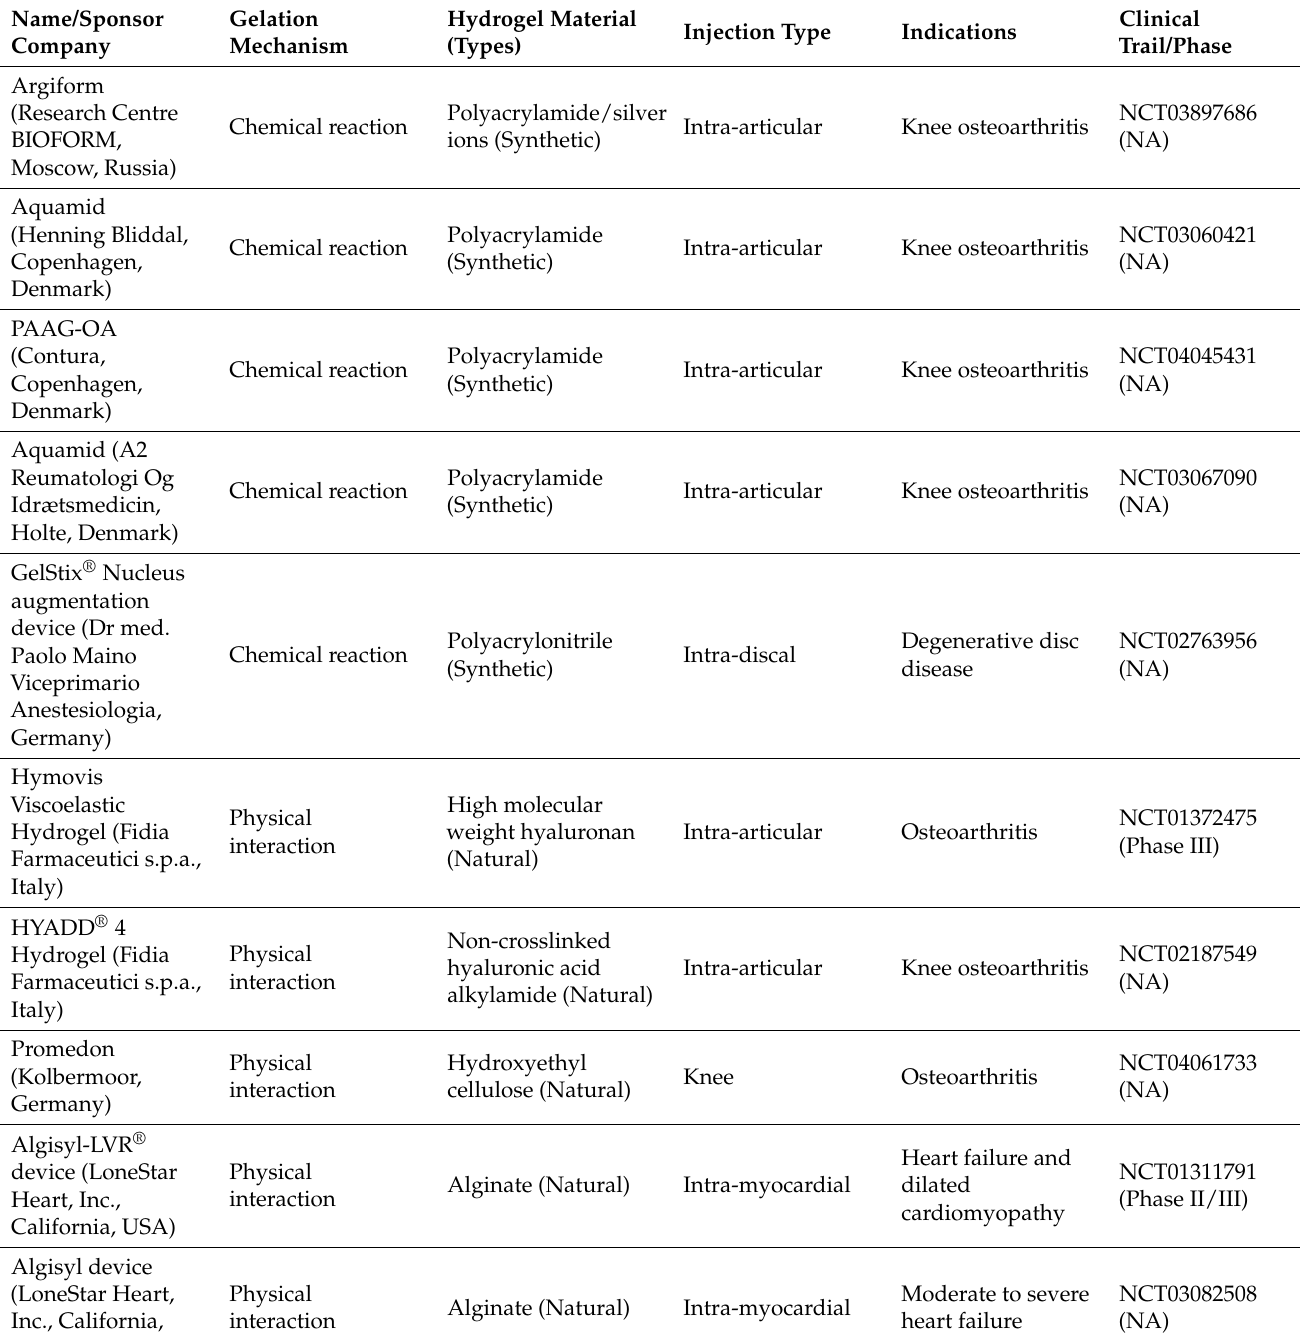
Table 3. Injectable hydrogels formulation that are under clinical